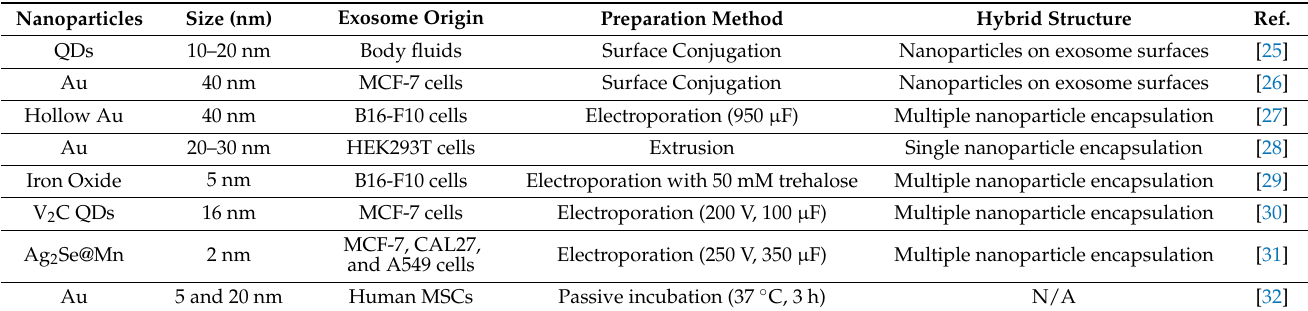
Table 1. A summary of inorganic nanoparticle-loaded exosomes through physical